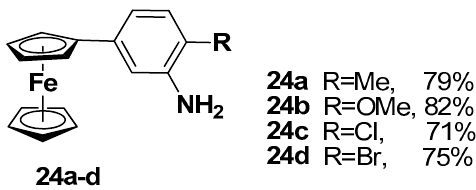
Figure 12. Ferrocene-modified anilines.